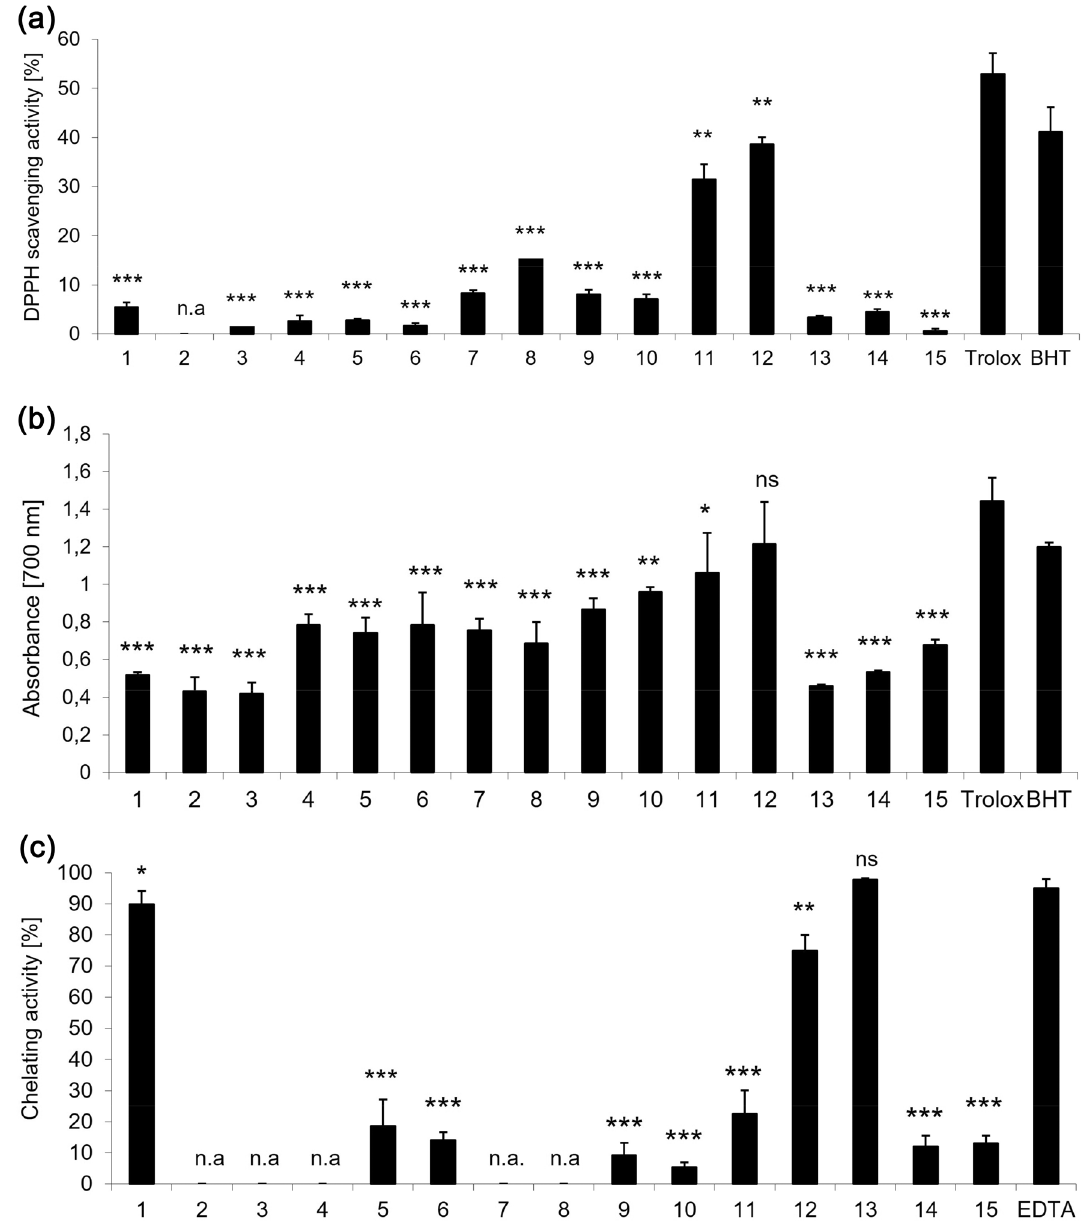
BHT. ( c ) Ferrous ions chelating activity of derivatives and standard chelating agent EDTA. All compounds were used at a concentration equal to 0.1 mg/mL. The results are presented as the mean value ± standard deviation (*** P < 0.001, ** P < 0.01, * P < 0.05) in comparison with standard antioxidants Trolox or EDTA, respectively. Inactive derivatives are indicated as n.a. Non statistically significant difference is indicated as